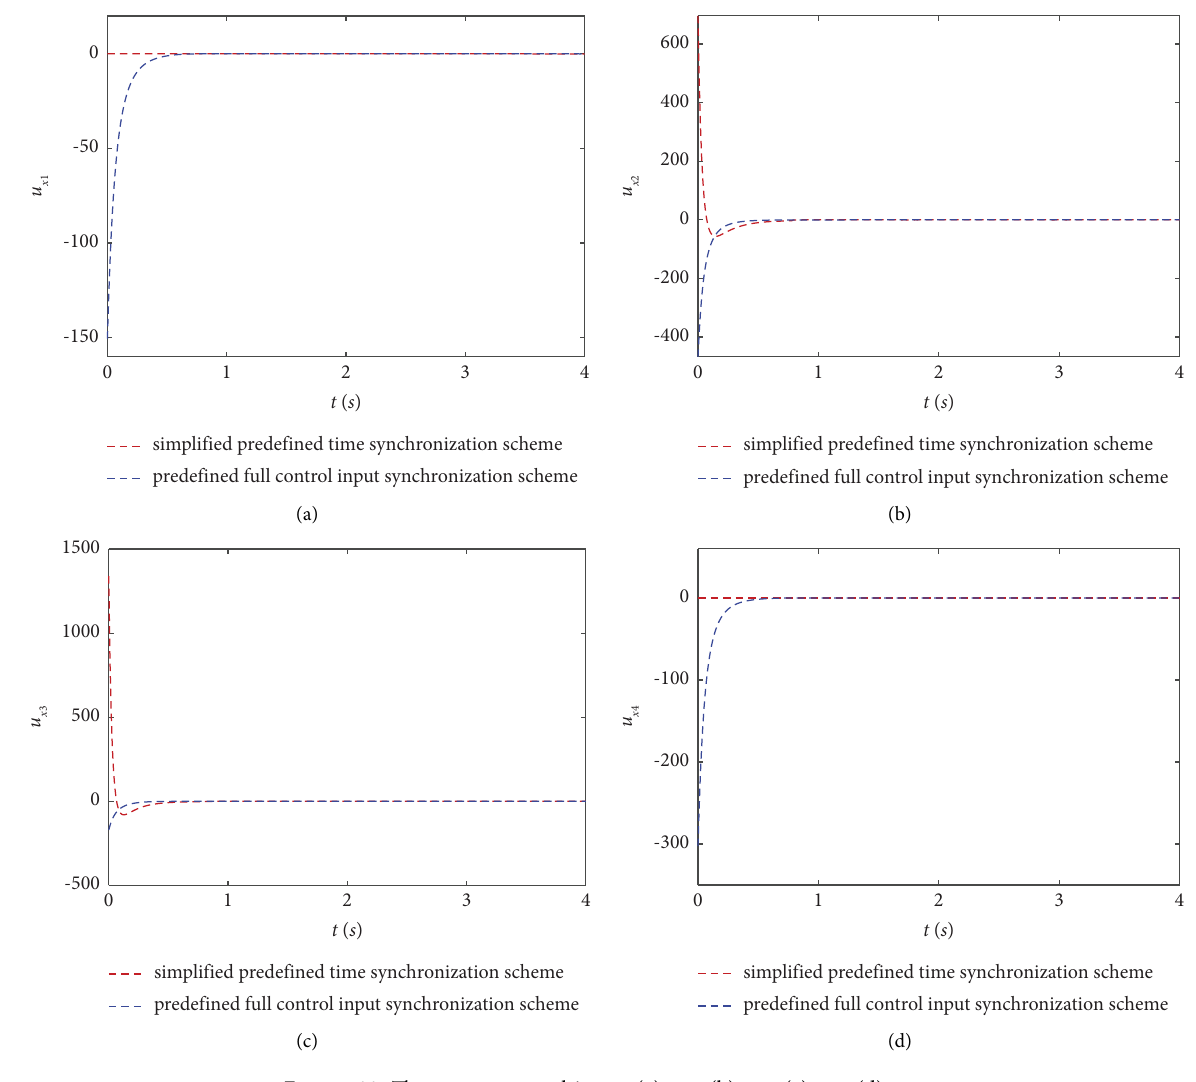
u u u x 1 ; (b) x 2 ; (c) x 3 ; (d) x 4